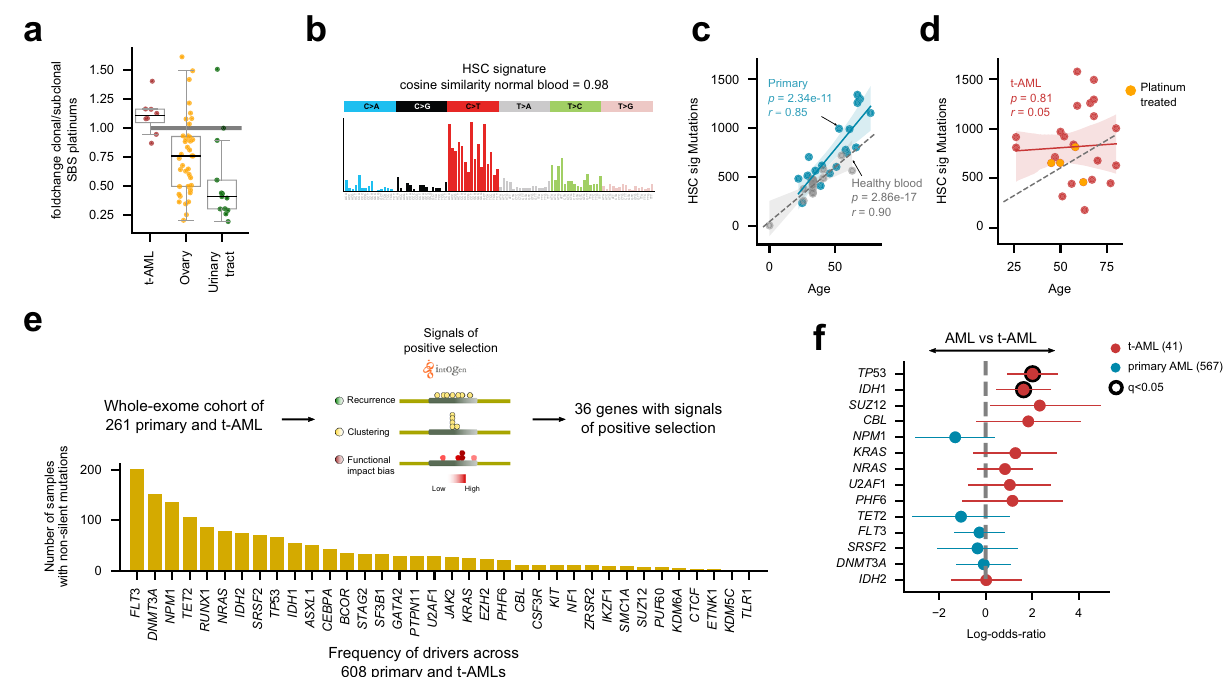
Fig. 3 The development of treatment-related AMLs. a Relative activity of platinum-related signature among clonal mutations (with respect to subclonal mutations) across tAMLs and the metastatic tumors of several organs of origin. The box in each boxplot delimits the fi rst and third quartiles of the distribution (with a line representing the median); the whiskers delimit the lowest data point above the fi rst quartile minus 1.5 times the interquartile distance and the highest data point below the third quartile plus 1.5 times the interquartile distance. b Mutational pro fi le of the HSC signature active across tAML cases. c Linear relationship between the age of patients and the number of HSC mutations of primary AMLs (blue dots). The gray dots correspond to healthy blood donors and thus the regression of their HSC mutation burden to the age represents the normal accumulation of mutations in the process of hematopoiesis. In the fi gure r represents the two-tailed Pearson ’ s correlation coef fi cient and p , its associated p -value. The shaded areas cover the 95% con fi dence intervals of the corresponding regression lines. d A non-signi fi cant regression is obtained between the HSC mutation burden and the age of patients with tAML. In the fi gure r represents the Pearson ’ s correlation coef fi cient and p , its associated p -value. The shaded area covers the 95% con fi dence intervals of the regression line. e Genes with detectable signals of positive selection across the subset of 261 AMLs of the WES AML cohort with a healthy control sample. The recurrence of mutation shown by the bars is measured across the entire cohort. f Overrepresentation of mutations of different genes across primary or treatment-related AMLs. Signi fi cant cases (Benjamini-Hochberg FDR < 0.05) appear circled. The bars represent the 95% con fi dence intervals of the log-odds ratio. SBS single base substitution, HSC hematopoietic stem cell, sig